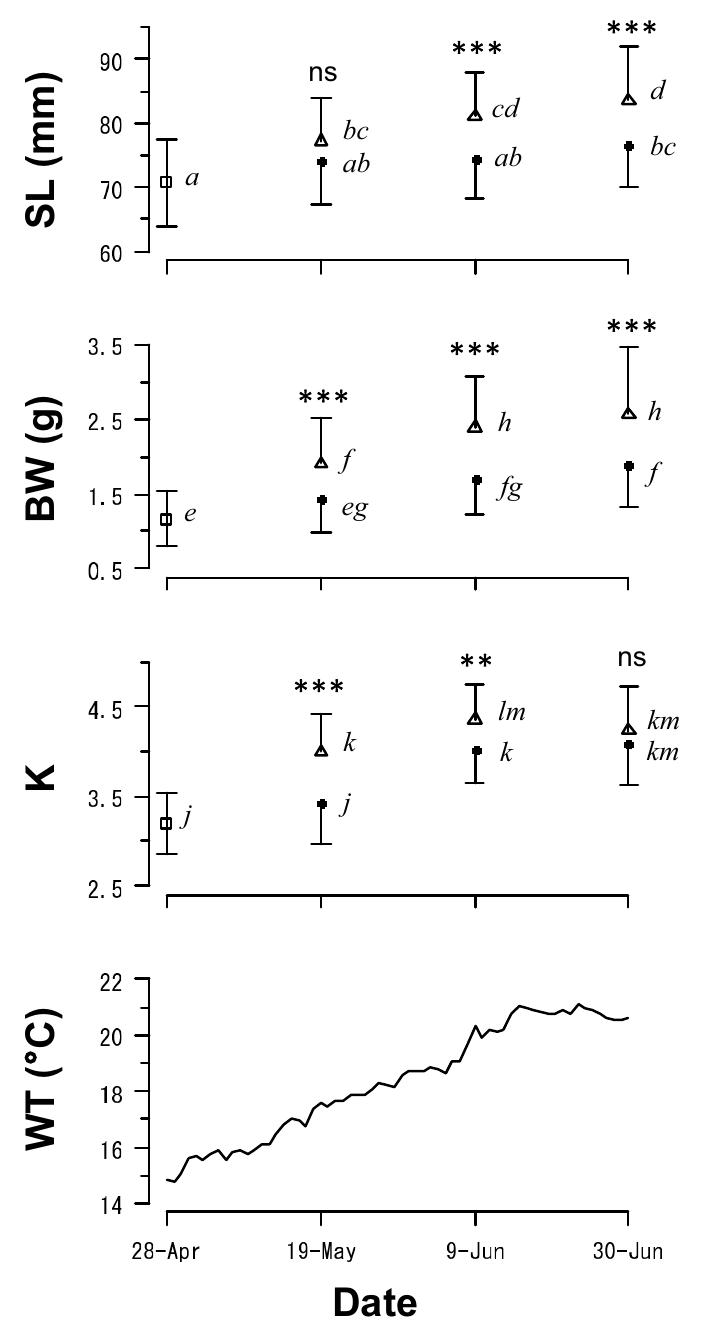
Fig 1. Temporal changes in the standard length (SL), body weight (BW), and condition factor (K) of western sand lance ( Ammodytes japonicus ) and associated water temperature (WT) in Experiment I. Open triangles and solid circles indicate high and low ration groups, respectively. Open squares indicate values at the beginning of the experiment. Data represent mean and standard deviation. Differences in SL, BW, and K between the ration groups were tested using one-way nested ANOVA ( � : p < 0.05, �� : p < 0.01, ��� : p < 0.001, ns: not significantly different). Different italicized letters indicate significant differences between groups (Tukey-Kramer test, p < 0.05).